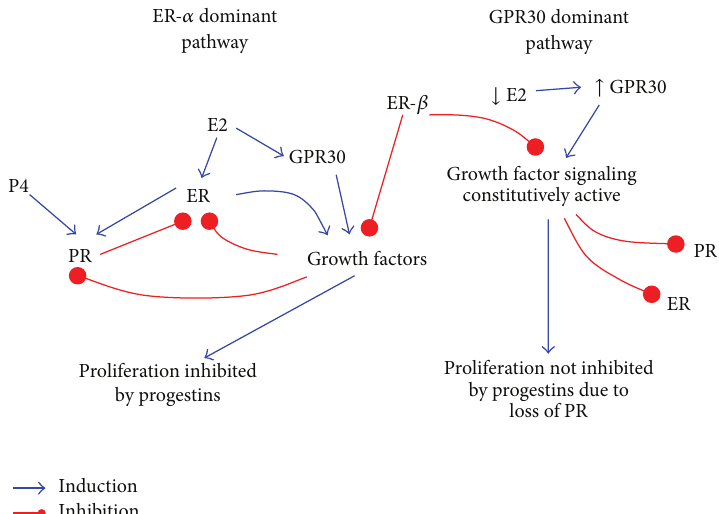
Figure 1: Hormone receptors in endometrial tumors. In ER- 𝛼 dependent tumors (left side), estrogen induces growth factors and PR through ER- 𝛼 . This creates a positive feedback loop between ER- 𝛼 and growth factor signaling. However, progesterone (P4), when bound to PR, downregulates ER and PR. In addition, MAPK activation downstream of growth factor signaling results in phosphorylation of ER and PR and the ligand-dependent loss of PR and ER proteins by ubiquitination-mediated proteasomal degradation. ER- 𝛼 and PR levels are increased again at the level of transcription by estrogen stimulation. Hence, the growth of these tumors is dependent upon estrogen and is limited by progesterone, suggesting that the patient will respond to progestin hormonal therapy. High expression of ER- 𝛽 , if present, can inhibit the function of ER- 𝛼 . For GPR30 dependent tumors (right panel), we hypothesize that proliferation is driven by the constitutive activation of one or more components of a growth factor pathway. Growth does not depend upon the presence of estrogen and is not limited by progesterone. Also, the classical steroid hormone receptors are downregulated as a result of constitutive phosphorylation via MAPK. This is predicted because the phosphorylation of the receptors leads to its targeting the proteasome for degradation. By virtue of the constitutive activation of a growth factor pathway, such tumors grow independently of classical hormonal